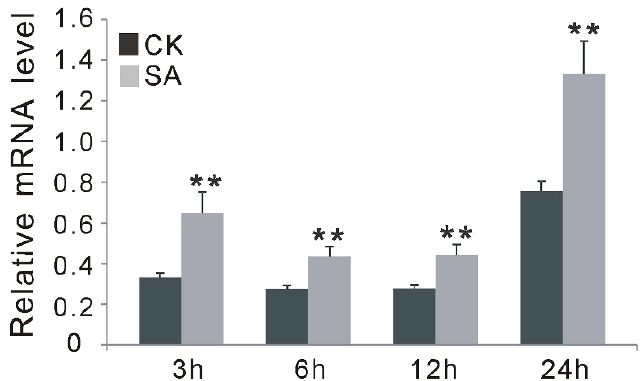
Figure 5. Time-course expression analysis of OsGF14f after SA and water (CK) treatments by quantitative RT-PCR analysis in Nipponbare plants. ** p < 0.01.